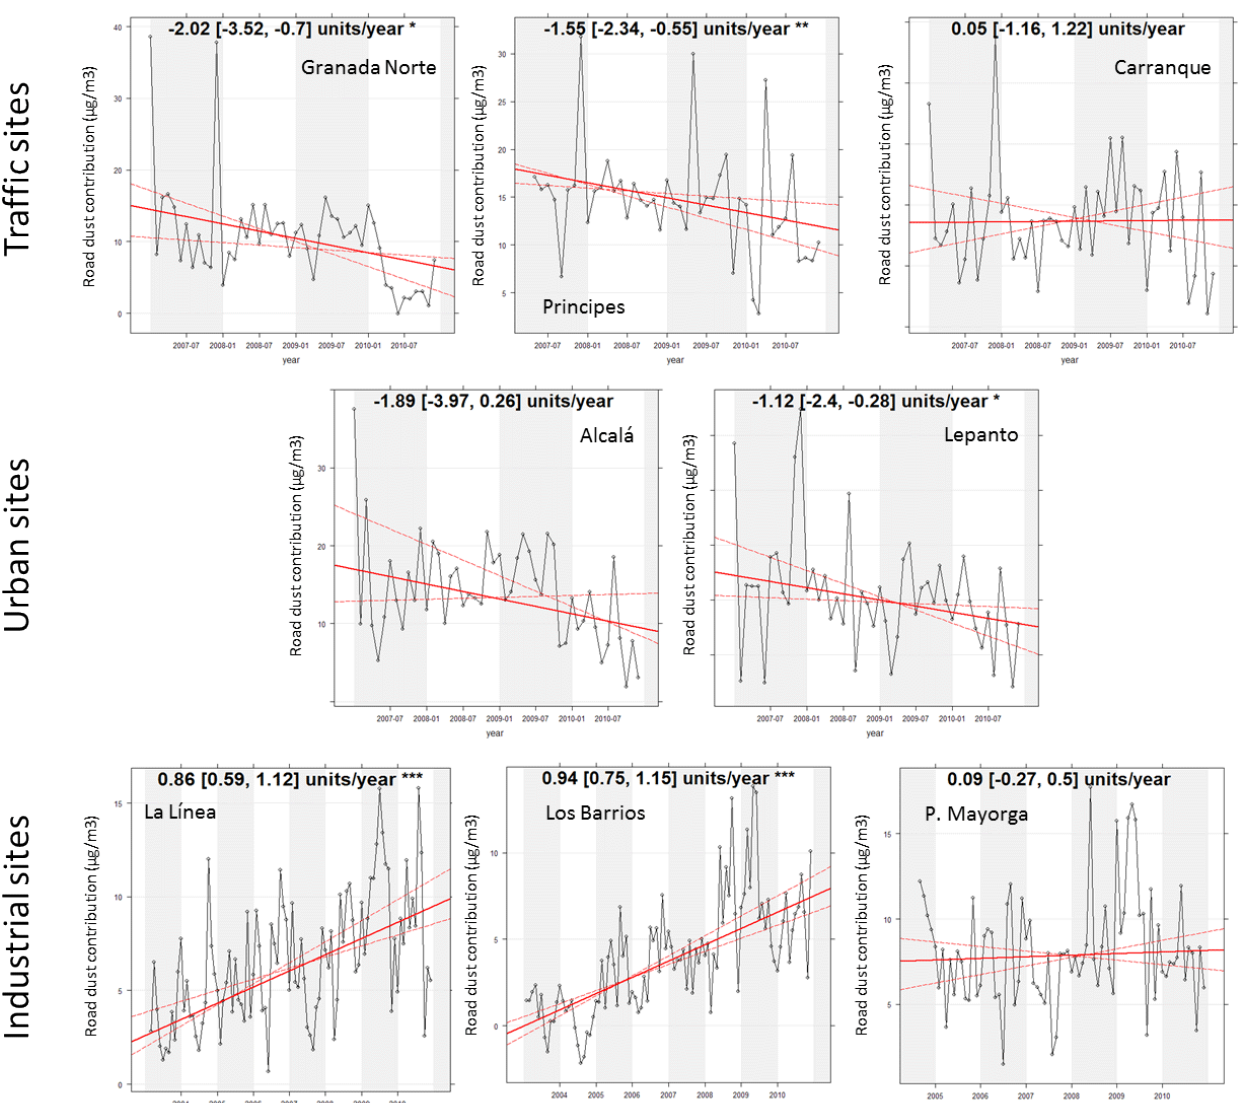
Fig. 6. Temporal trends for road dust contribution in PM 10 at traffic (Granada, Seville and Málaga), urban background (Seville and Córdoba) and industrial sites (Algeciras Bay). The plots show the deseasonalized monthly mean concentrations. The solid red line shows the trend estimate and the dashed red lines show the 95% confidence intervals for the trend. The overall trend and the 95% confidence intervals in the slope (in square brackets) are shown at the top as units (µgm − 3 ) per year. One, two and three asterisks indicate that the trends are significant to the 0.05, 0.01 and 0.001 levels,